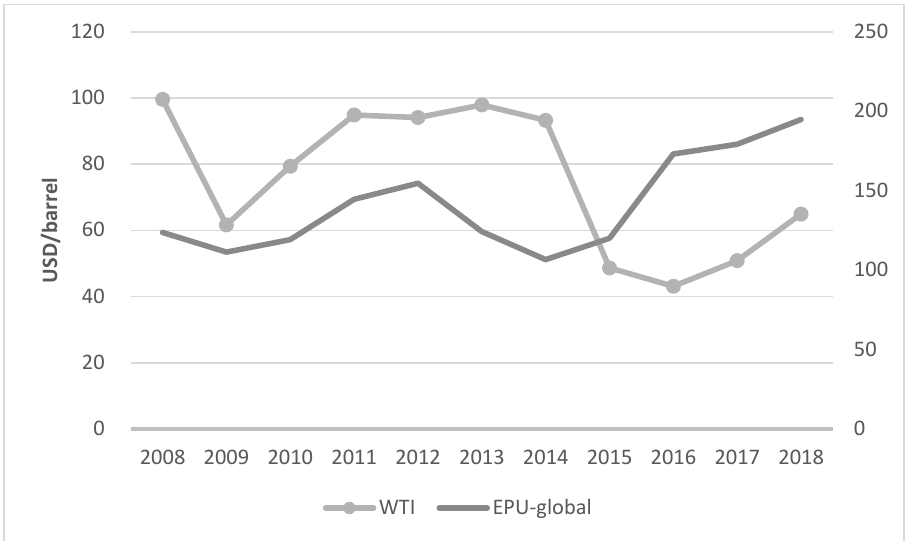
Figure 1. Trend of international crude oil prices (the left axis) and EPU-global (the right axis) from 2008 to 2018. The data are from the WTI crude oil price published by the US Energy Information Administration and the global economic policy uncertainty index calculated by Becker et al.